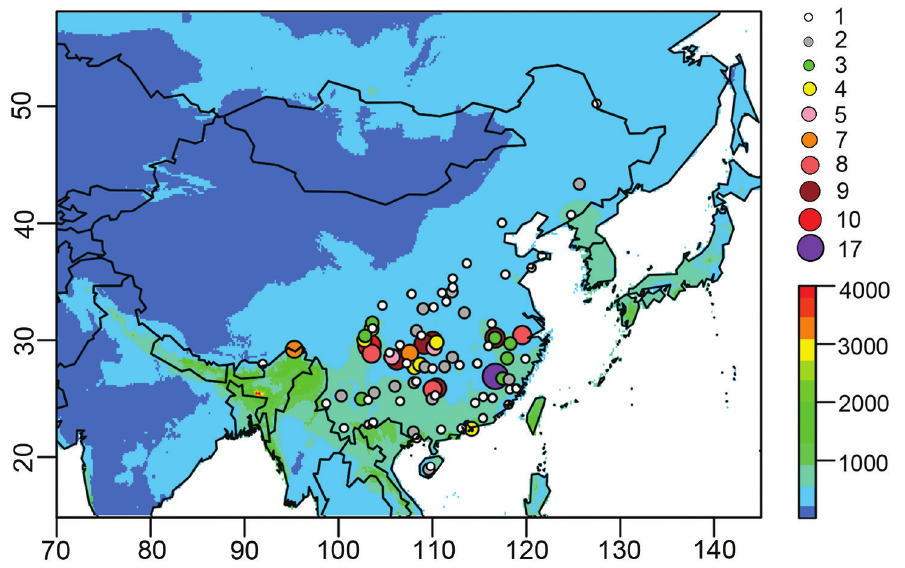
Figure 11. Geographical distribution of Glaucocharis in China and precipitation of the warmest quarter (Bio18). Circles indicate surveyed sites and numbers of species per site. Rainbow bar: precipitation